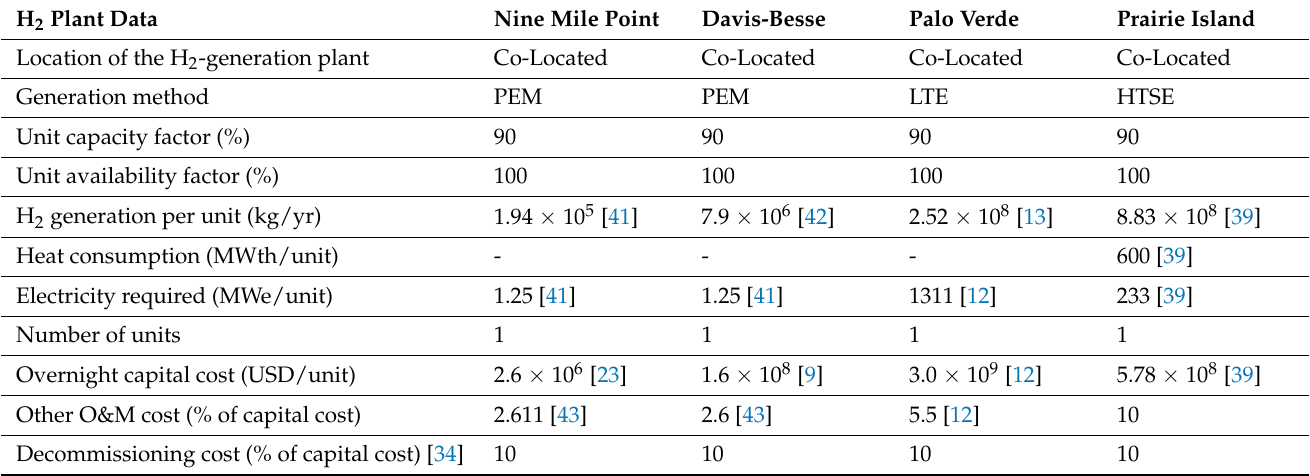
Table 3. Hydrogen plant input data for estimation of the hydrogen-production cost.